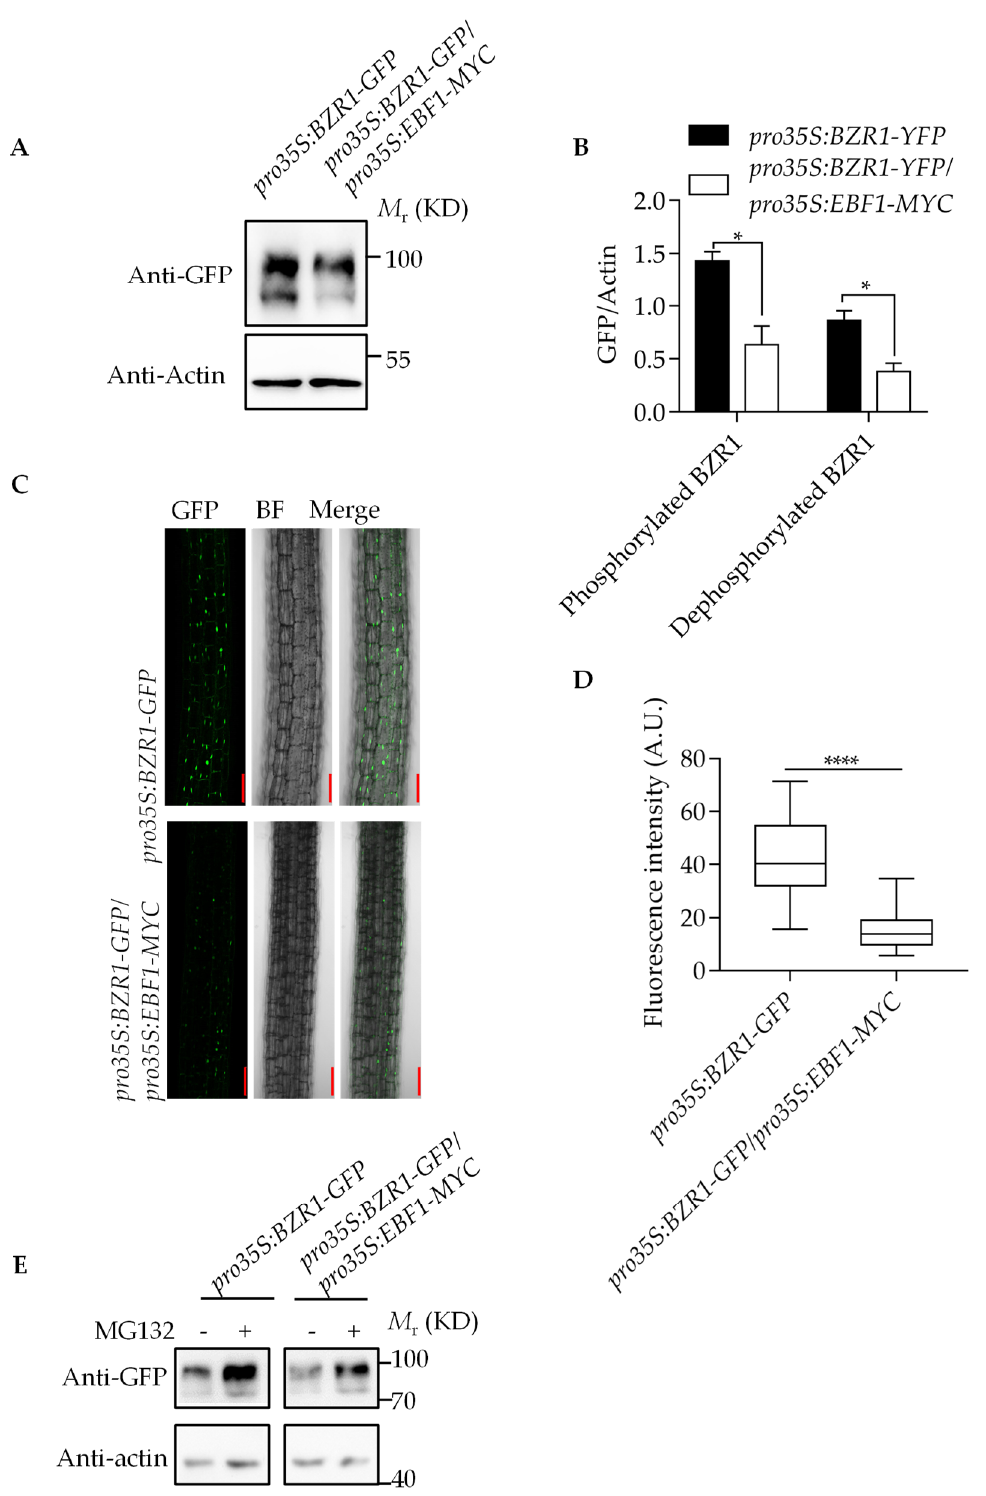
Figure 4. EBF1 promoted the ubiquitination and degradation of BZR1. ( A , B ) The protein level of BZR1 in transgenic Arabidopsis plants expressing pro35S:BZR1-GFP only or co-expressing pro35S:EBF1-MYC and pro35S:BZR1-GFP . Seedlings were grown in ½ MS medium for 7 days in in white light. BZR1 was detected with anti-GFP antibody. Actin was used as a control. ( B ) The quantification of BZR1-GFP level displayed in ( A ). GFP/Actin: ratio of immunoblot image intensities between GFP and Actin. Error bars represent the SD of three independent experiments. * p < 0.05, as determined